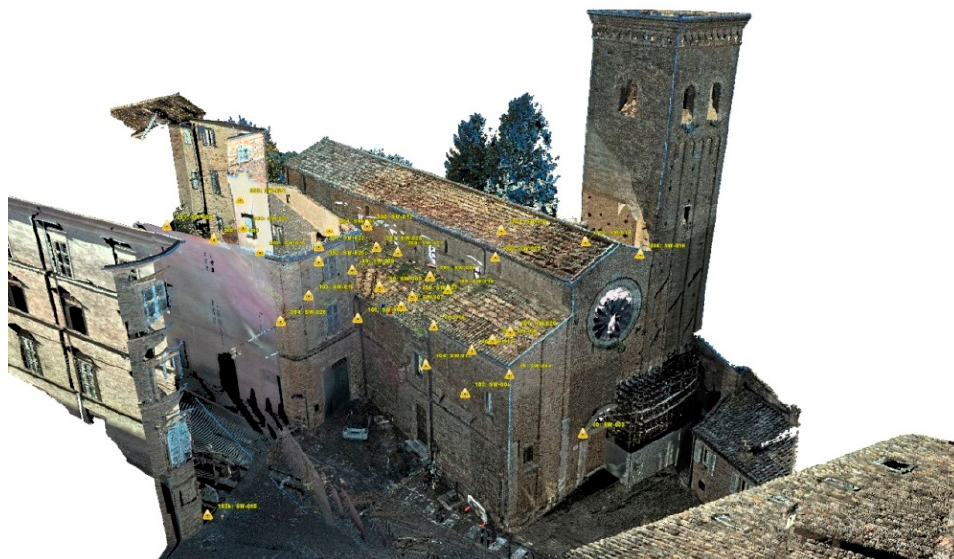
Figure 4. Point cloud with targets of the laser scanner and total station.